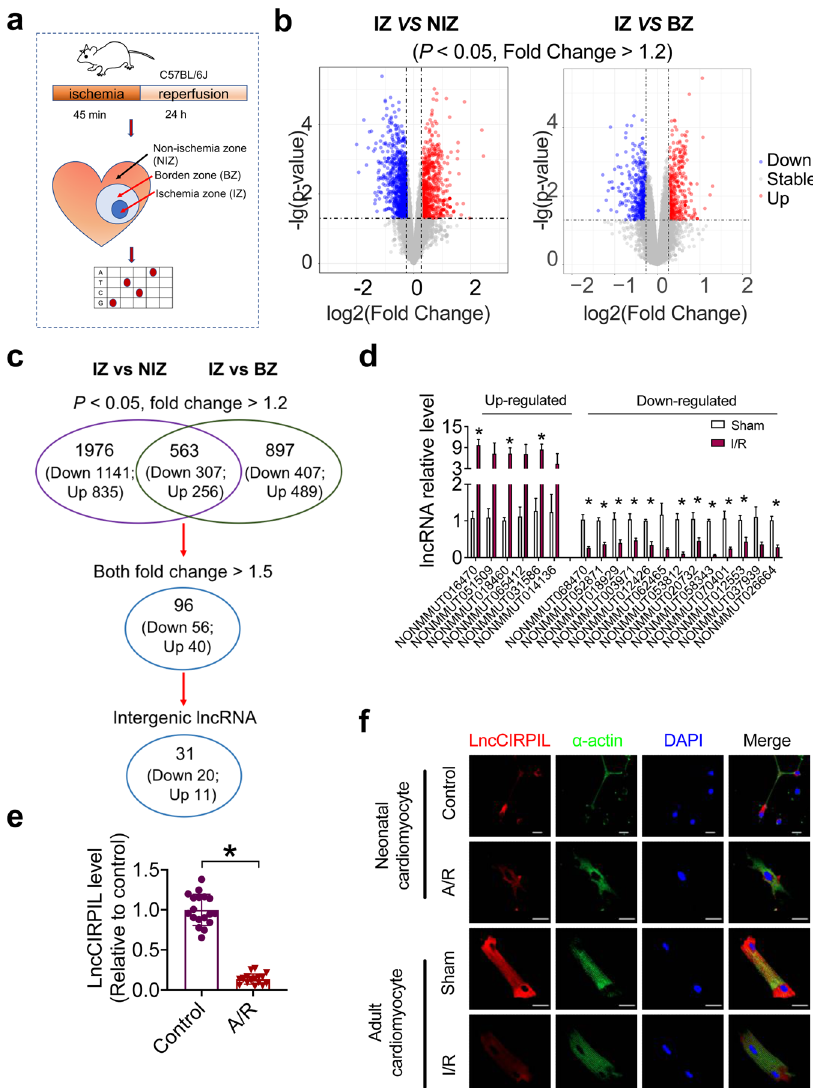
Fig. 1 LncRNA-CIRPIL is downregulated in ischemia/reperfusion (I/R) hearts and anoxia/reoxygenation (A/R) NMCMs. a The fl owchart of study of I/ R-induced expression pro fi les of murine lncRNA by MTA 1.0 transcriptome microarray assay. b The volcano plots of the I/R-induced expression pro fi les of murine lncRNAs in ischemia zone (IZ) compared with non-ischemia zone (NIZ) and border zone (BZ). n = 3. c Analysis of dysregulated lncRNAs in the hearts of I/R mice based on microarray pro fi ling. d Validation of the heart-enriched and with more than 1.5 folds change intergenic lncRNAs in the hearts of I/R mice. n = 5. * P < 0.05 vs sham by two-tailed Student ’ s t test. e The expression changes of lncCIRPIL in NMCMs exposed to A/R. n = 18 samples from 6 independent experiments. * P < 0.05 vs control by two-tailed Student ’ s t test. f . Subcellular localization of lncCIRPIL in NMCMs and adult mouse cardiomyocytes detected by Fluorescent in situ hybridization (FISH) & Immuno fl uorescence (IF) after A/R or I/R injury. n = 3. Scale bar = 20 μ m. DAPI indicates 4 ′ from lncCIRPIL-TG mice relative to WT mice (Fig. 3g, h). The Bcl2/Bax ratio was higher in I/R hearts of lncCIRPIL-TG mice than WT mice (Fig. 3i). These data indicated that lncCIRPIL protects the heart from I/R injury by inhibiting apoptosis.